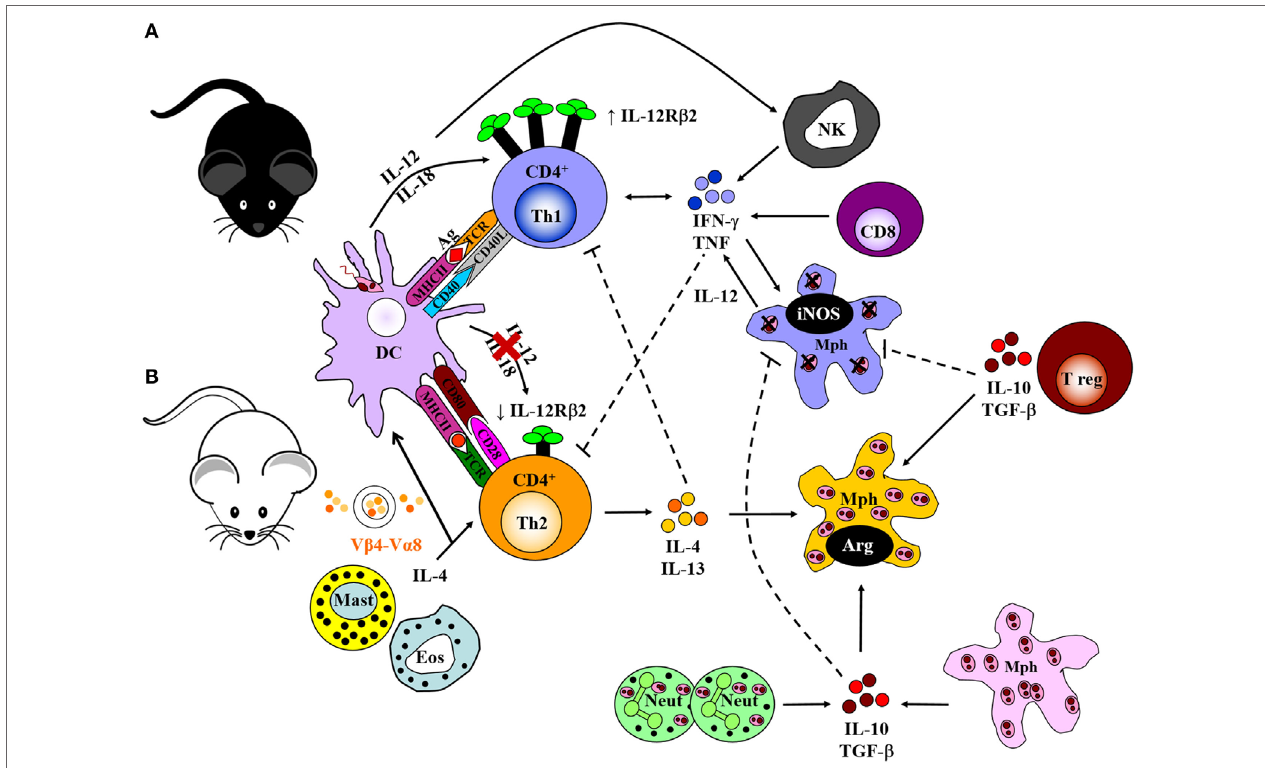
FiGURe 2 | Cell-mediated immune response to Leishmania major in resistant and susceptible mice. (A) Upon interaction with L. major parasites, activated dendritic cells (DCs) process and present parasite antigen and produce IL-12 and IL-18, which interact with the IL-12 receptor β 2-chain (IL-12R β 2) in activated Th1 cells. Together, a dominant Th1 response is generated by the production of IFN- γ and TNF- α . These cytokines upregulate the expression of inducible nitric oxide synthase (iNOS) and activate infected macrophages for intracellular killing. CD8 + T cells and natural killer (NK) cells control infection by producing IFN- γ and effector killing by macrophages leading to parasite control as observed in C57BL/6 mice. (B) By contrast, parasite persistence in BALB/c mice is due to the failure of an IL-12- dependent redirection of the early Th2 response. This may be due to continued expression of early interleukin-4 (IL-4) from V β 4 + V α 8 + CD4 + T cells, mast cells, and eosinophils at the inoculation site and draining lymph nodes. This delays secretion of IL-12, or loss of responsiveness to IL-12 due to reduced expression of the IL-12R β 2 chain on activated Th2 cells. IL-4 and IL-13 suppress Th1 responses and inhibit intracellular killing by macrophages. This leads to arginase production by macrophages that favor parasite growth. Sustained neutrophil recruitment to the site of infection and regulatory T cells may promote susceptibility and inhibit Th1 responses by the production of IL-10 and TGF- β that inhibit activation of macrophages. Solid lines represent activation, and broken lines represent inhibition. Illustration drawn from previous publications (6, 75,